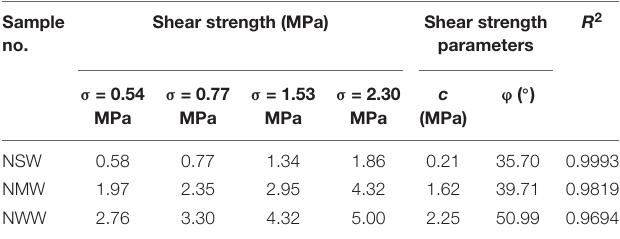
TABLE 4 | Shear strength parameters of the numerical diorite-porphyrite model. Sample Shear strength (MPa) Shear strength R 2 no. parameters